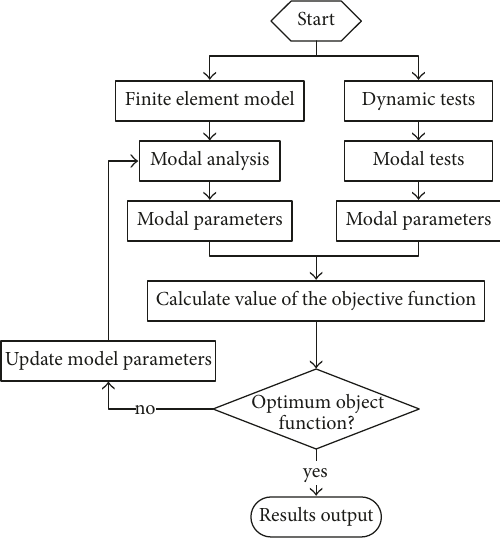
Figure 2: Flow chart of the finite element model updating